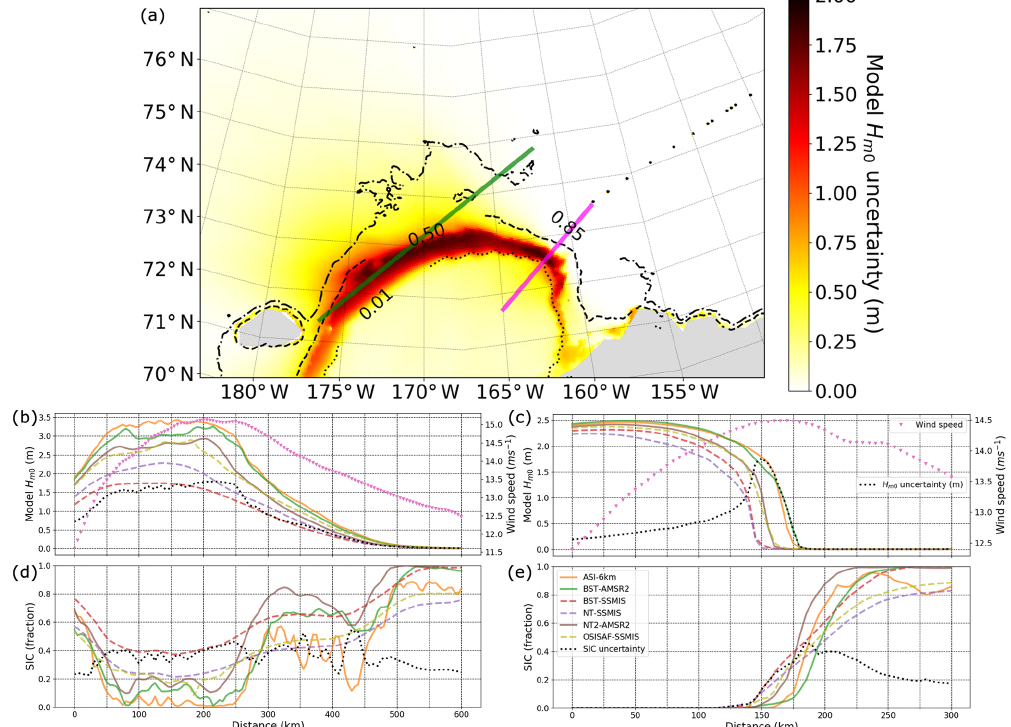
(c) and SIC 0 and (cid:49)c i . 0